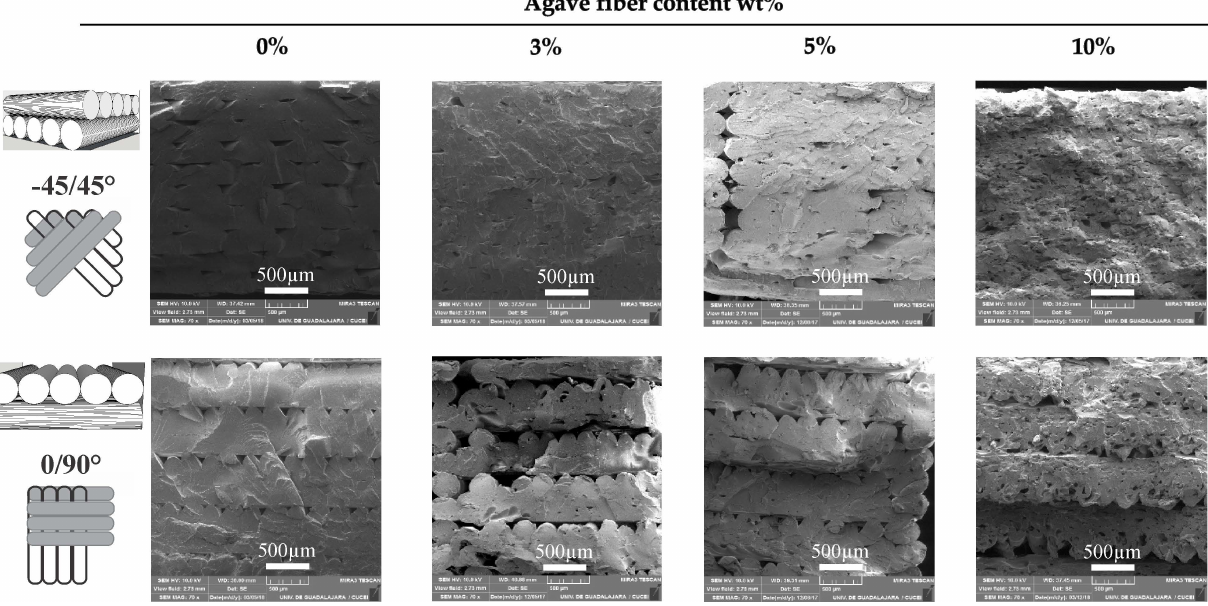
Figure 2. SEM micrographs of agave fibers/PLA biocomposites with different agave fiber content (0, 3, 5 and 10 wt%) and angle deposition ( − 45 ◦ /45 ◦ and 0 ◦ /90 ◦ ) (70 ×